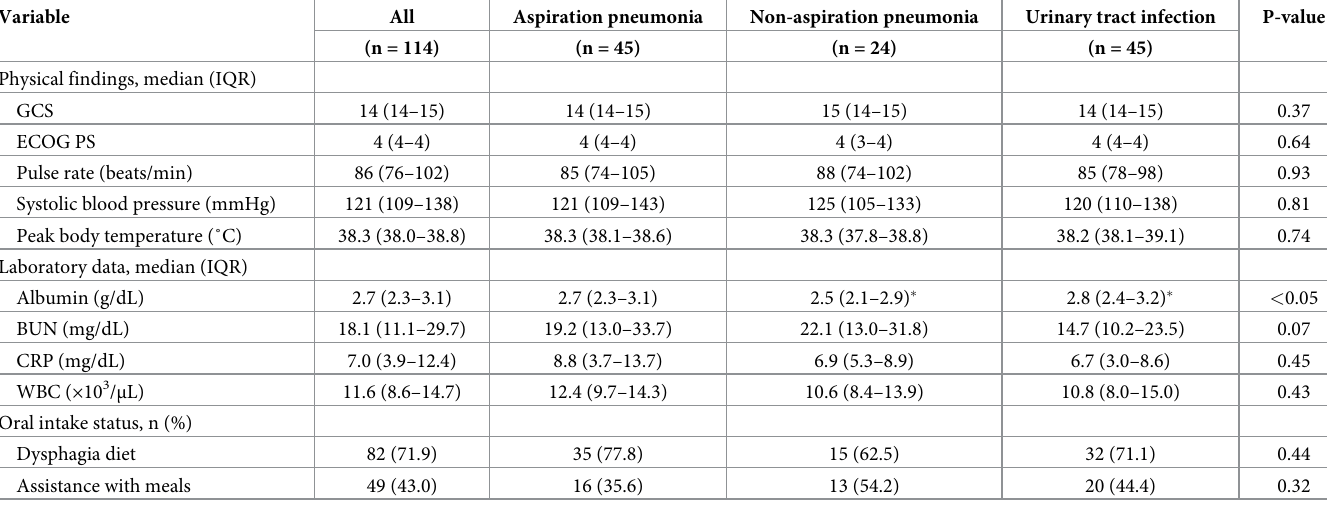
Table 2. Clinical findings and laboratory data at the onset of